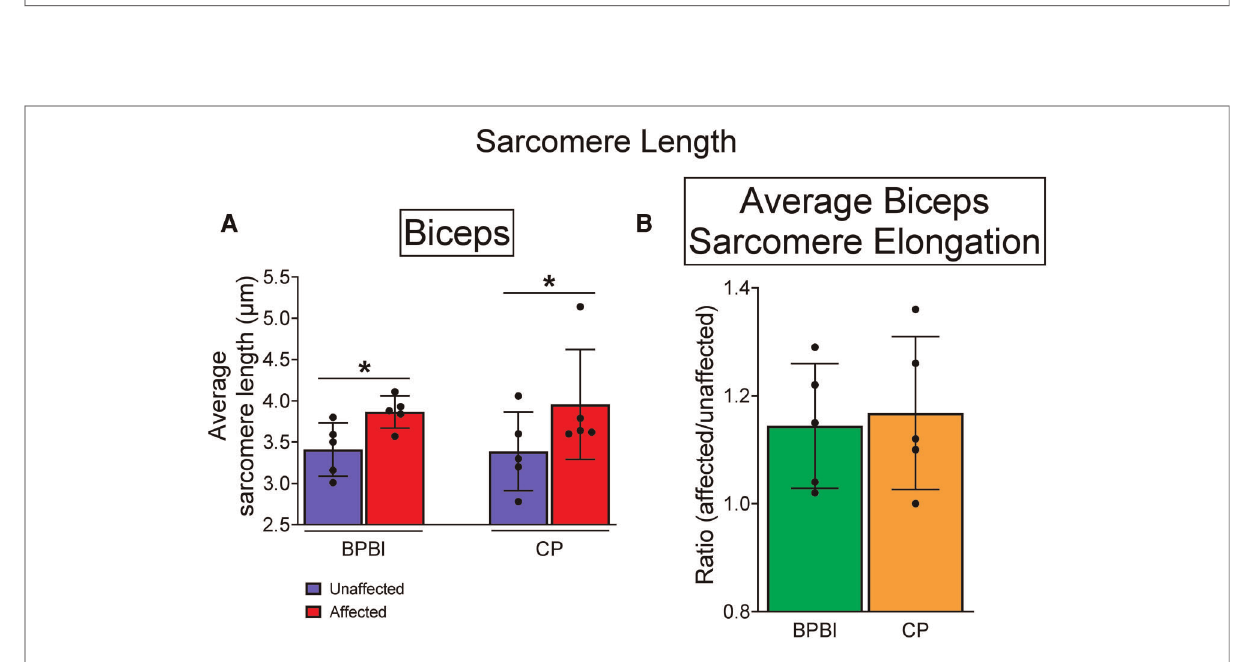
FIGURE 4 Sarcomere lengths in BPBI and CP subjects. ( A ) Average sarcomere lengths for biceps brachii muscles were longer on the affected versus unaffected sides for both BPBI and CP subjects. ( B ) The degree of sarcomere elongation, or overstretch, did not differ between BPBI and CP subjects. * p